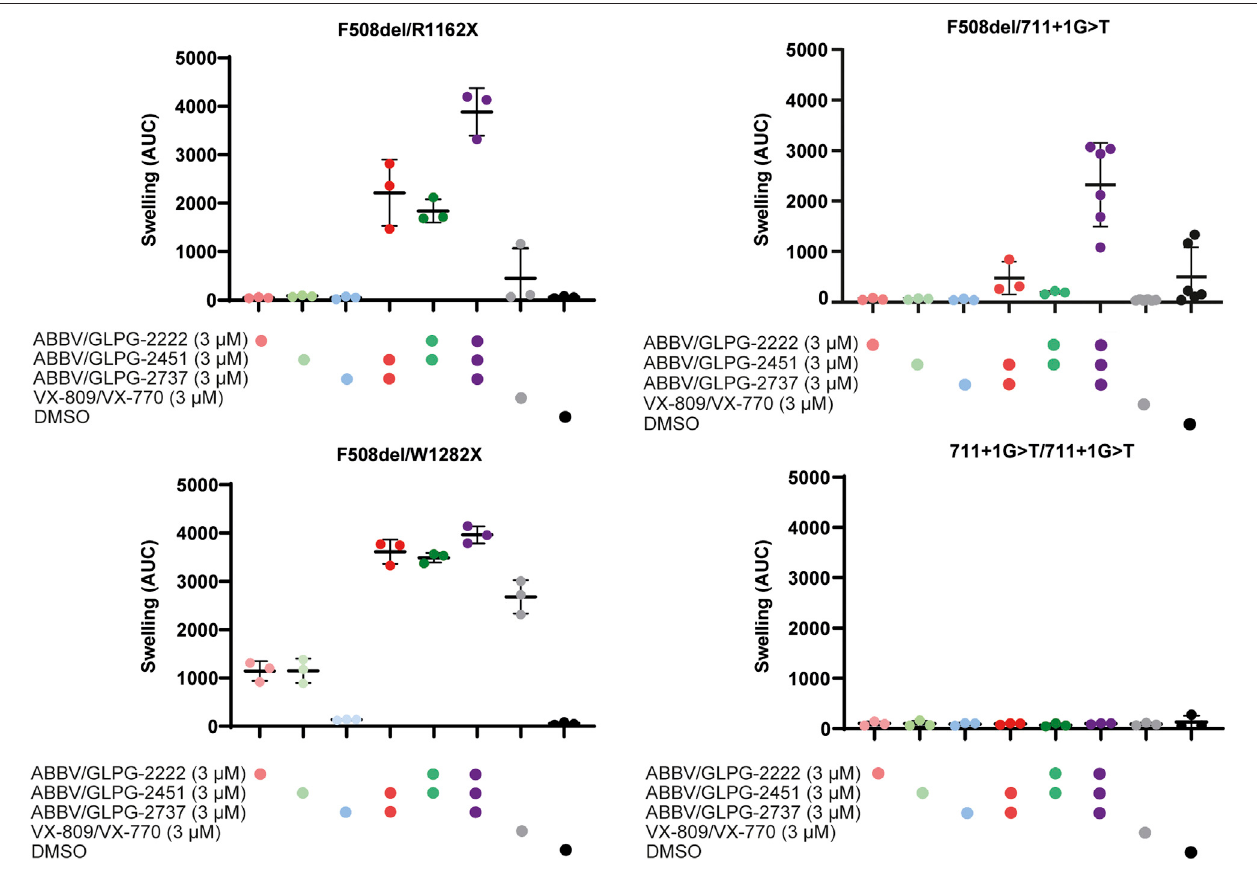
FIGURE 1 | CFTR function rescue with single, dual and triple ABBV/GLPG modulator therapy in intestinal organoids. FIS responses of three organoid cultures expressing F508del/minimal function genotypes and one organoid culture homozygous for 711+1G > T, stimulated with 5.0 µM forskolin for 1h. FIS responses were measured upon treatment with ABBV/GLPG compounds, VX-809/VX-770 and DMSO. n (cid:1) 3 or n (cid:1) 6, each bar represents mean ±